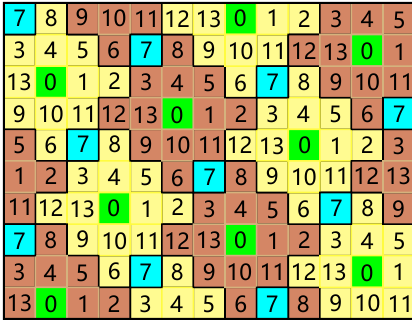
Figure 2: The almost lattice packing of Z 2 by Lee spheres of radius 2 associated with S